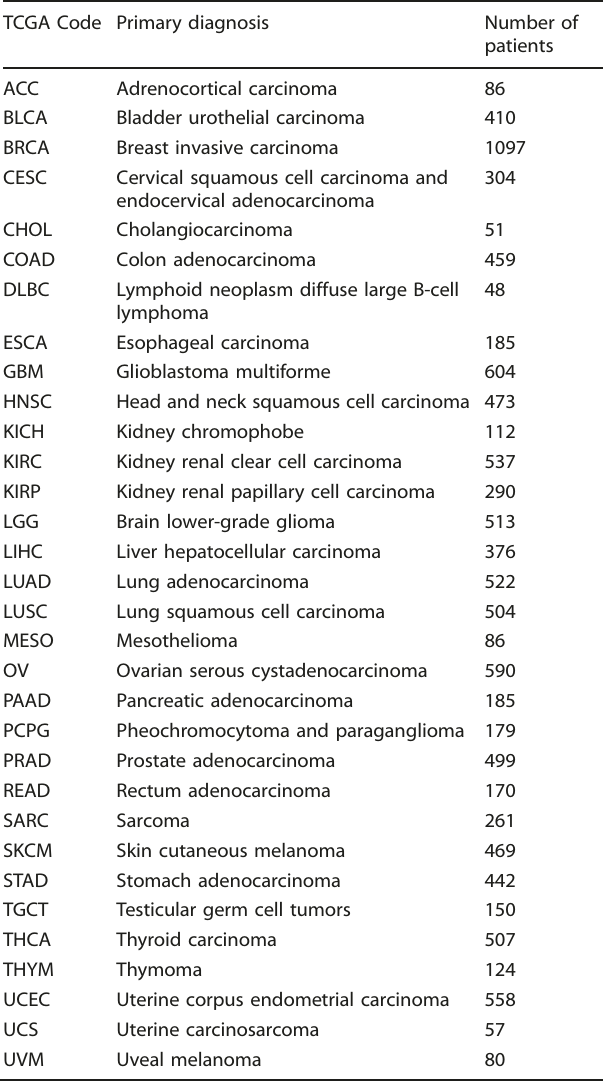
Table 5. The TCGA codes (in alphabetical order) of all 33 primary diagnoses and corresponding number of evidently diagnosed patients in the data set (TCGA = The Cancer Genome Atlas).